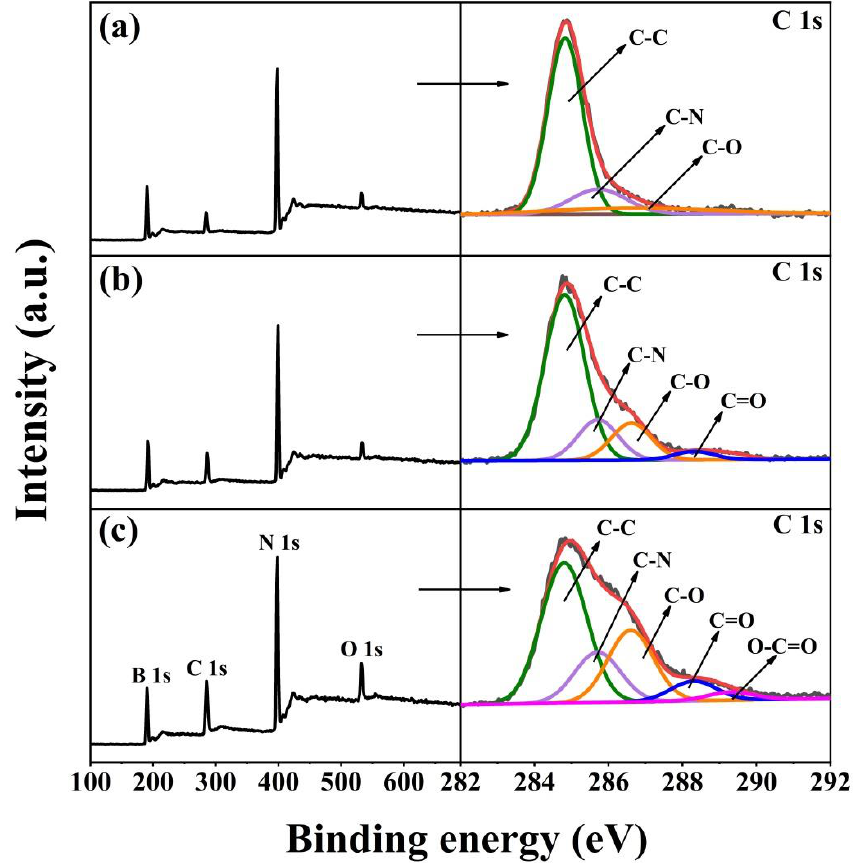
Figure 2. TGA curves of hBN, mhBN, and mhBN@GO.